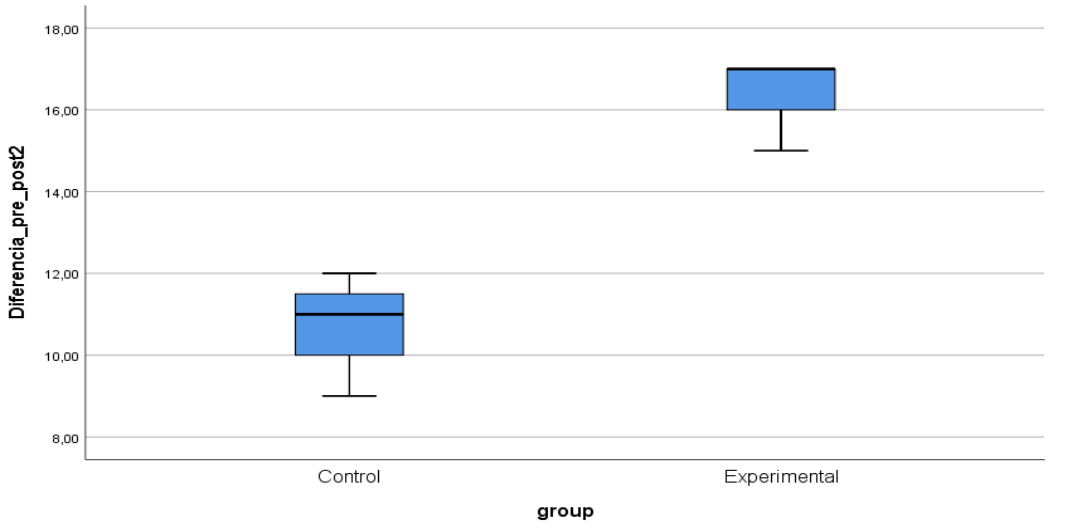
Figure 10. Difference in means control and experimental groups